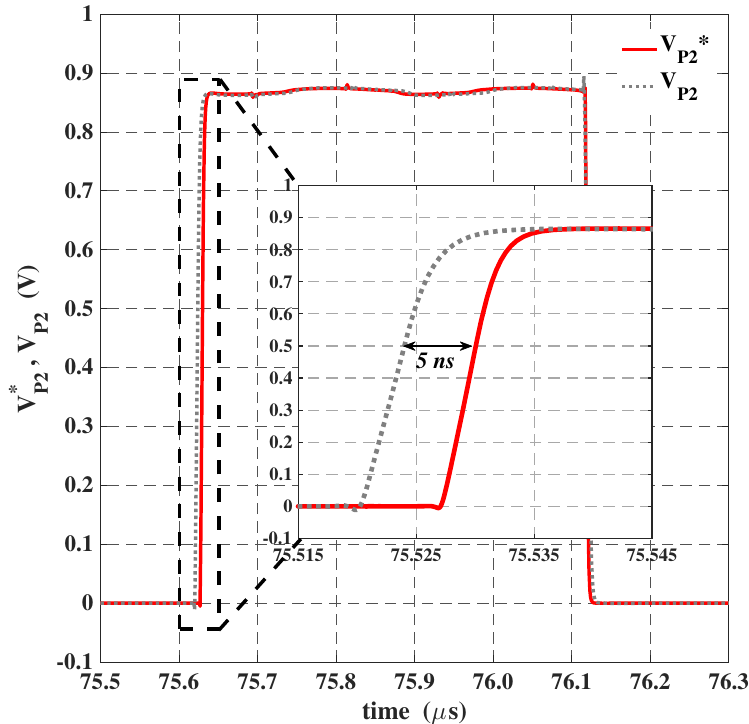
Figure 14. Pre-Layout ( V P 2 ) vs. Post-Layout ( V ∗